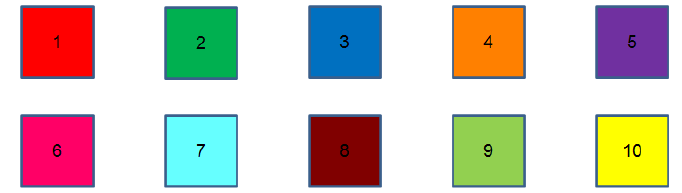
Figure 5. Available colors to establish person-color associations.